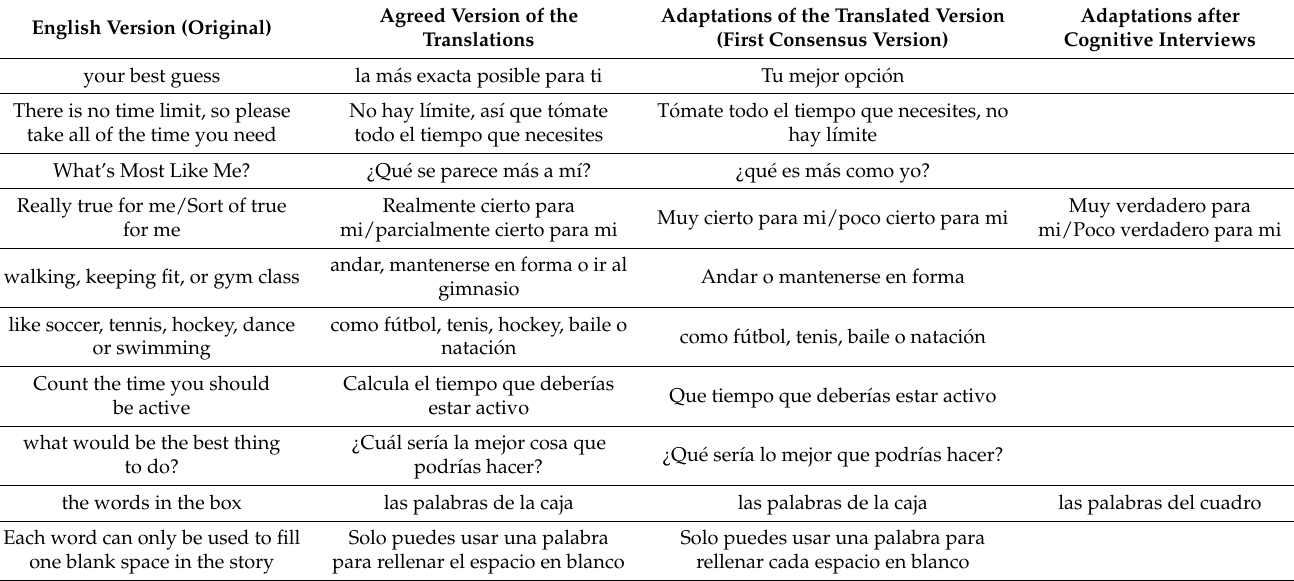
Table 2. Adaptations made from the initial translated version to the final version of the questionnaire. Agreed Version of the Adaptations of the Translated Version Translations (First Consensus Version)